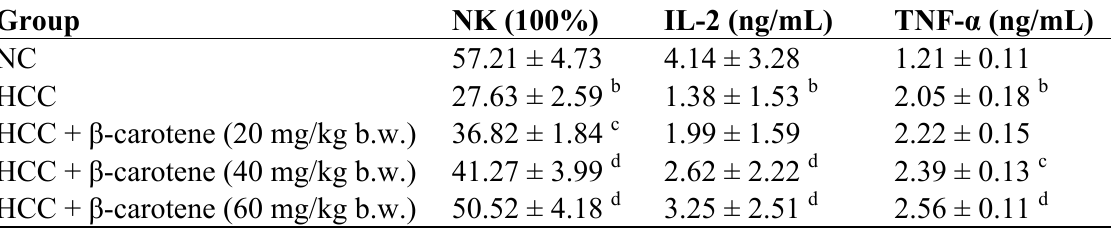
Table 2. Effect of β -carotene on NK, IL-2 and TNF- α in